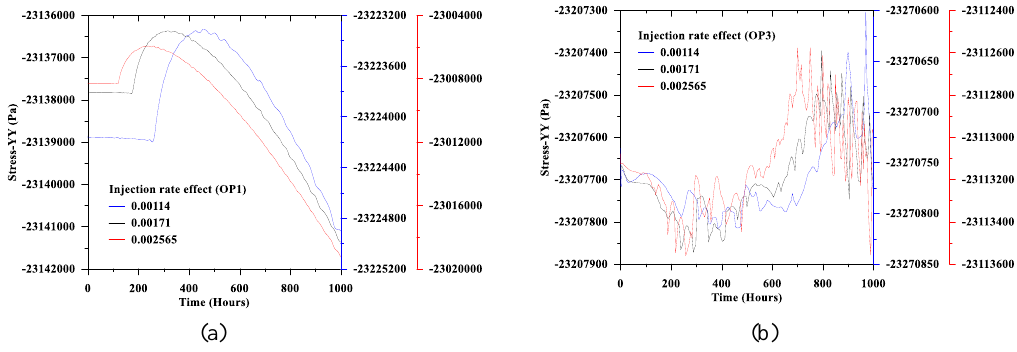
Figure 16. Injection rate e ff ect on the x -axis stress: ( a ) OP1 and ( b ) OP3. Figure 16. Injection rate effect on the x -axis stress: ( a ) OP1 and ( b ) OP3. Figure 16. Injection rate effect on the x -axis stress: ( a ) OP1 and ( b ) OP3. Figure 16. Injection rate effect on the x -axis stress: ( a ) OP1 and ( b ) OP3. Figure 16. Injection rate effect on the x -axis stress: ( a ) OP1 and ( b ) OP3.